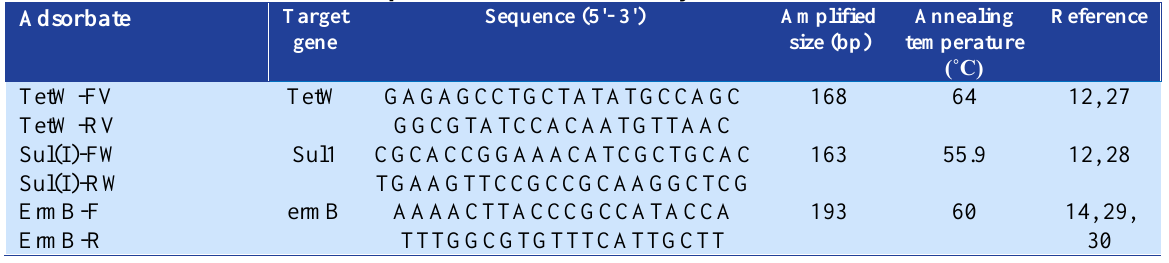
Table 1. Characteristics of primers used in the